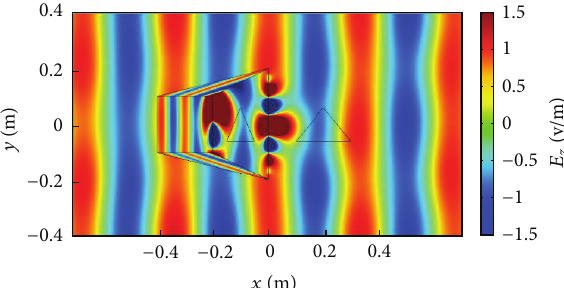
Figure 4: A trapezoid complementary cloak used to cloak a triangle object outside the